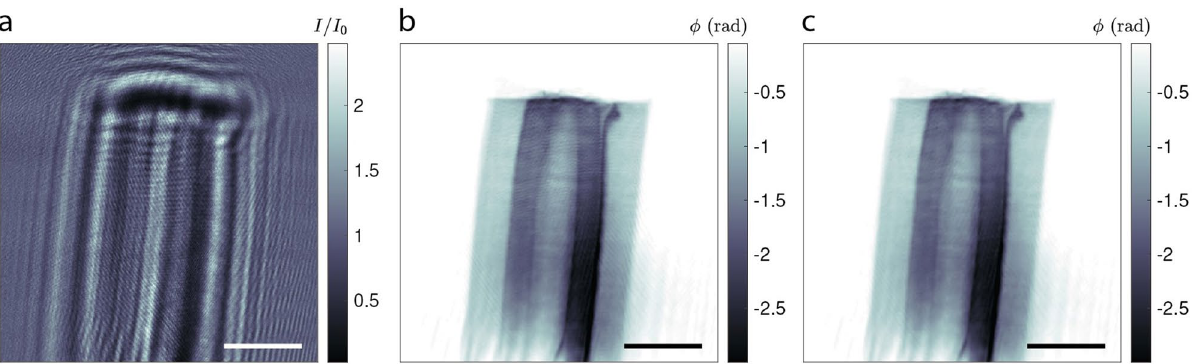
Figure 2. NFH measurement of the pine specimen. ( a ) Flat-field corrected NFH image ( I / I 0 ) at a Fresnel number of F = 10 −4 . ( b ) The recovered phases ( (radian)) of the specimen. The stripe artifacts from the illumination leave an imprint in the reconstruction. ( c ) The result of a morphological component analysis on ( b ) ϕ to remove the artifacts. Scale bars: 10